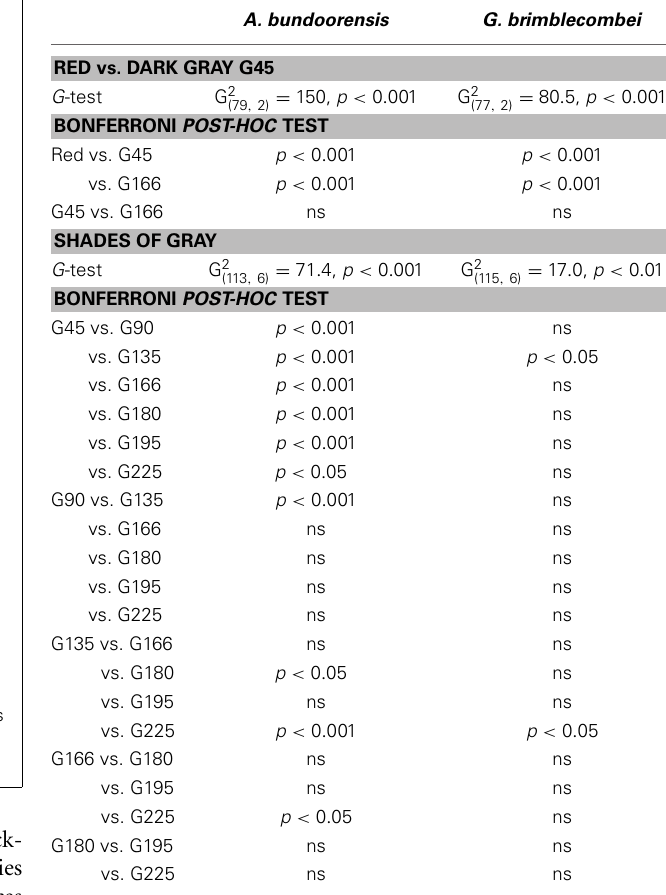
1 with an overall reflectance greater than that of the back- ground G166. However, for none of the four species ( Figure 7A ).